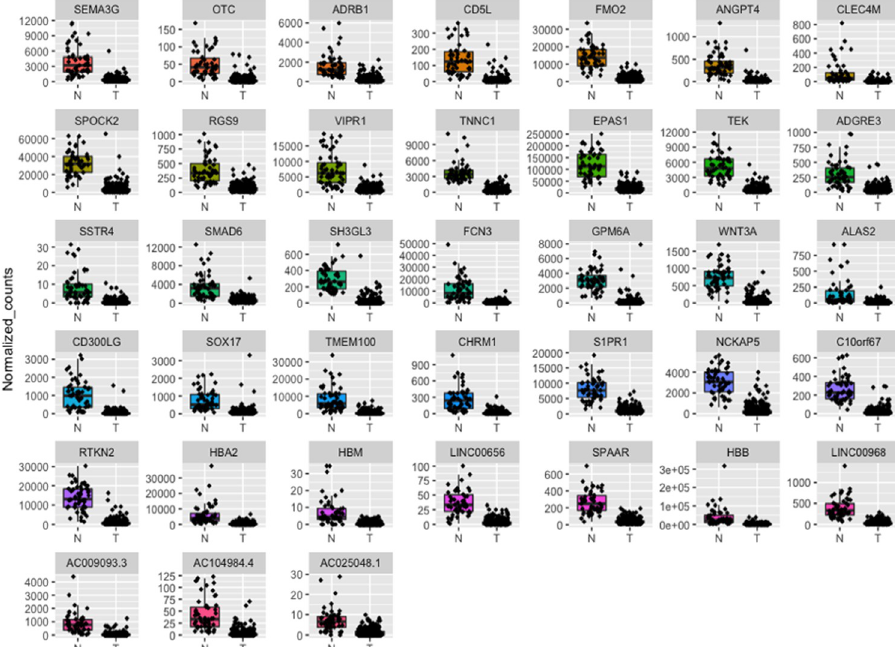
Fig 12. Boxplots representing the expression level of the RFE-RF common genes in LUAD patients in comparison to normal samples. N represents normal tissues and T represents tumor tissues.